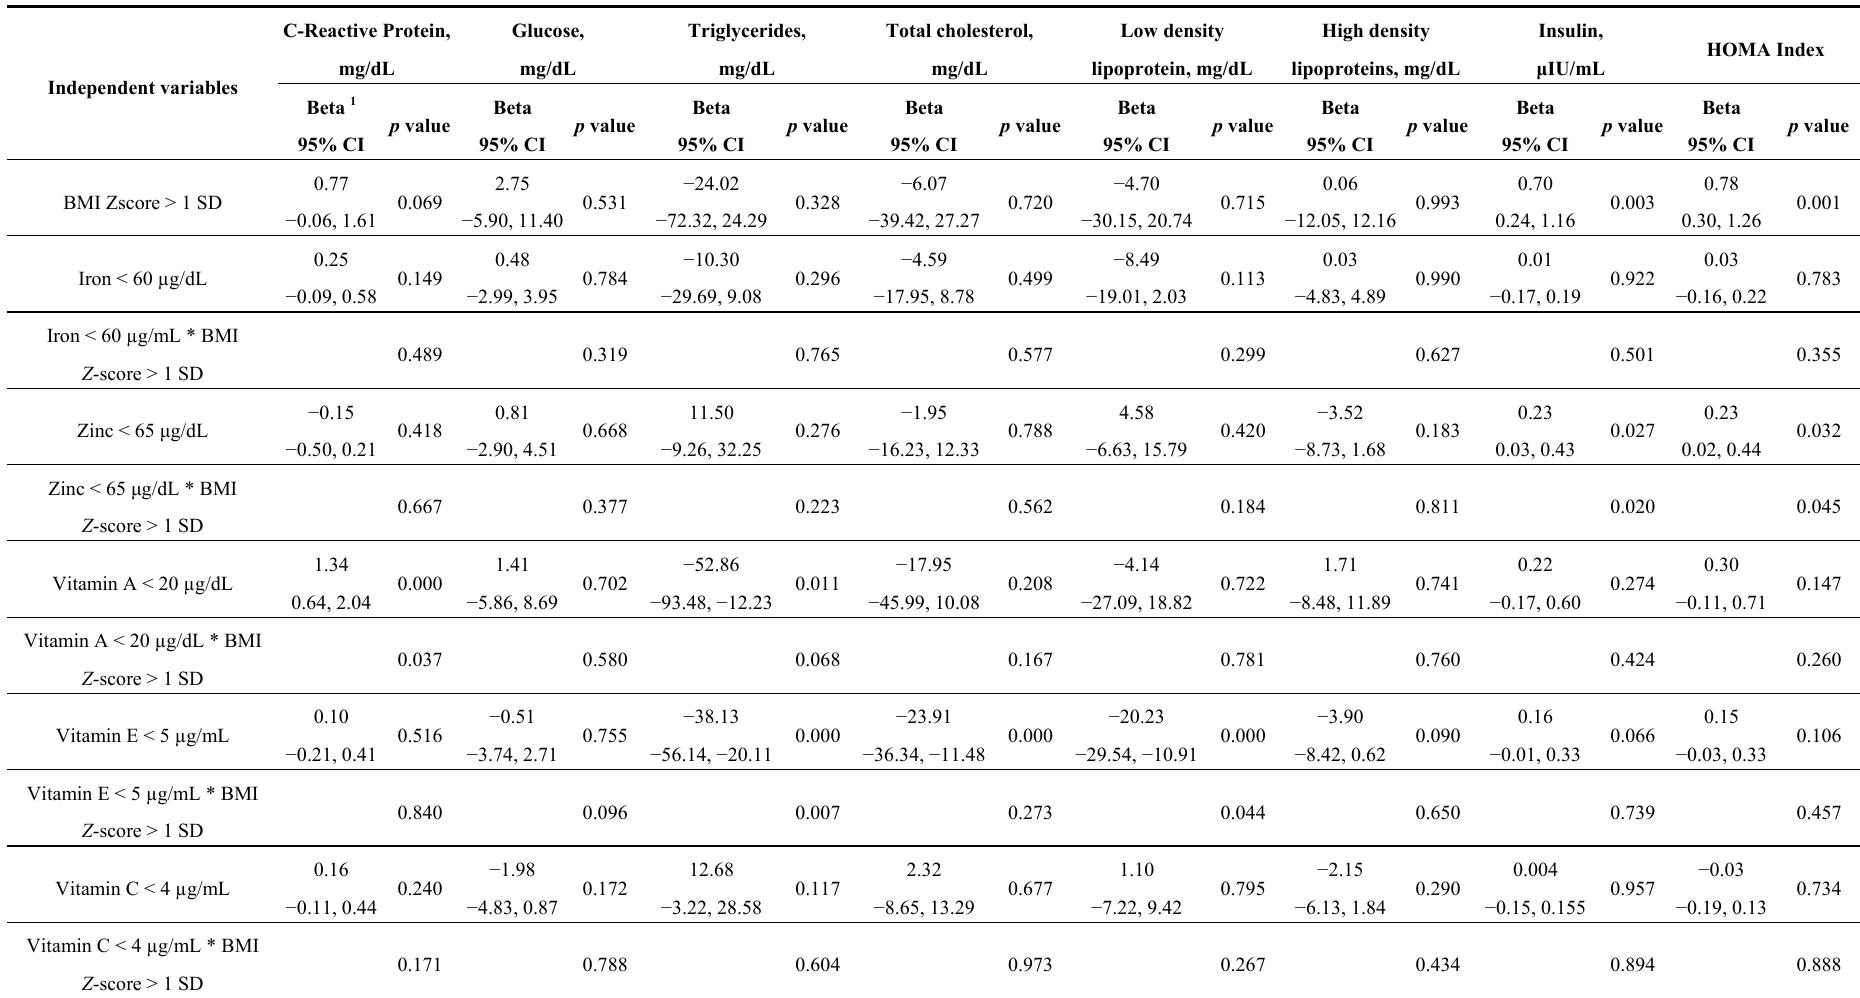
Table 5. Linear models to predict biochemical variables from micronutrients and their interaction with being overweight and obesity ( n = 197) 1